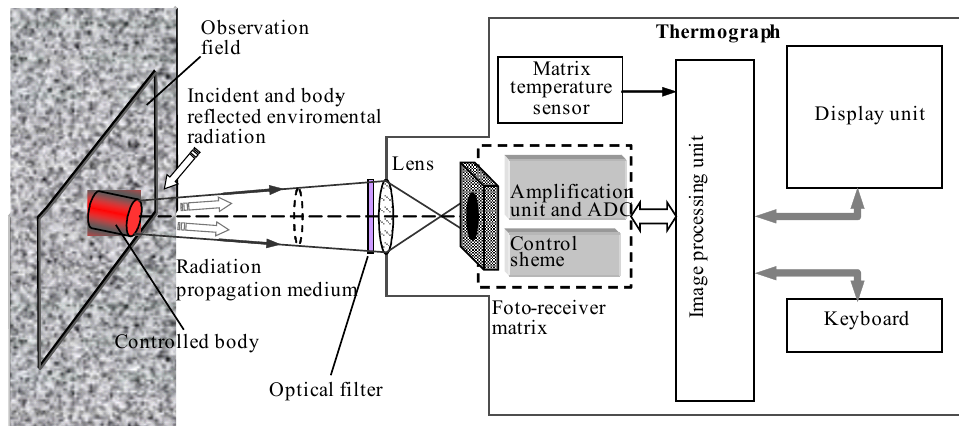
Figure 2. Scheme of temperature control with a thermograph based on a matrix of photodetectors and its functional diagram.